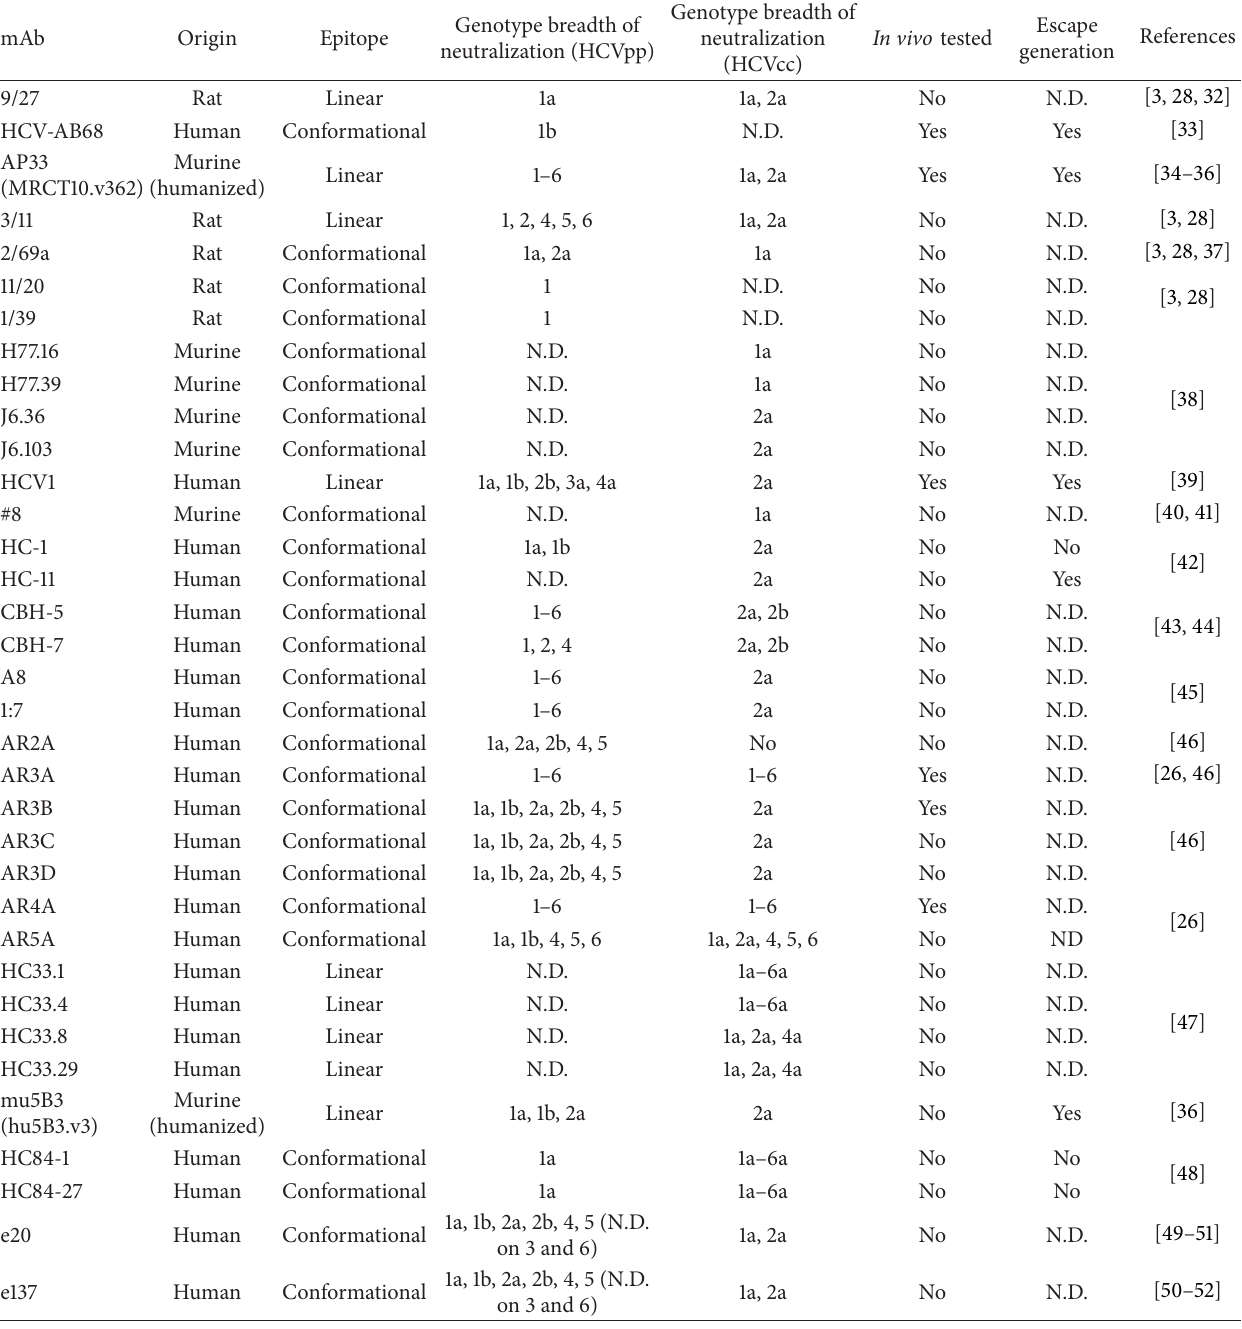
Table 2: Synopsis of broadly anti-HCV/E2 neutralizing